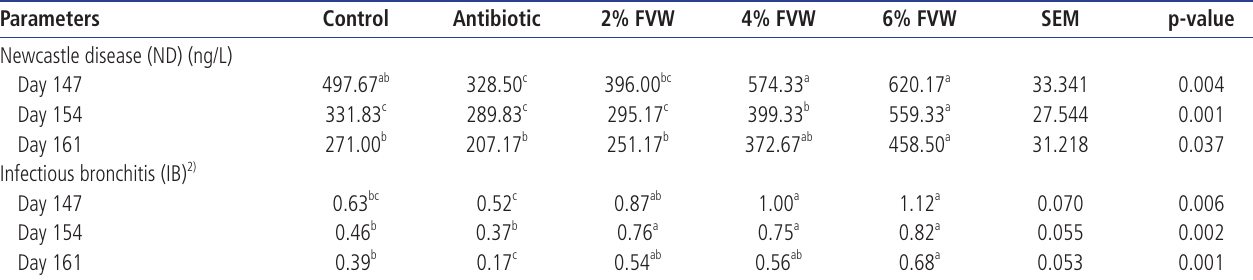
SEM, pooled standard error of the means. 1) Data represented the mean value of 7 hens per treatment.